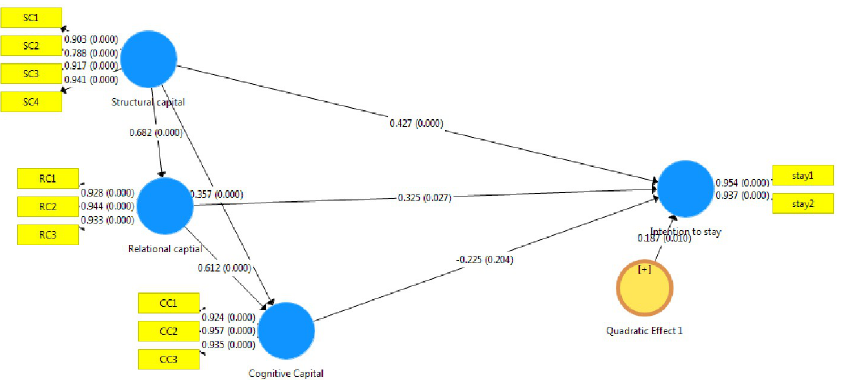
Fig 2. Partial least squares SEM model (source: